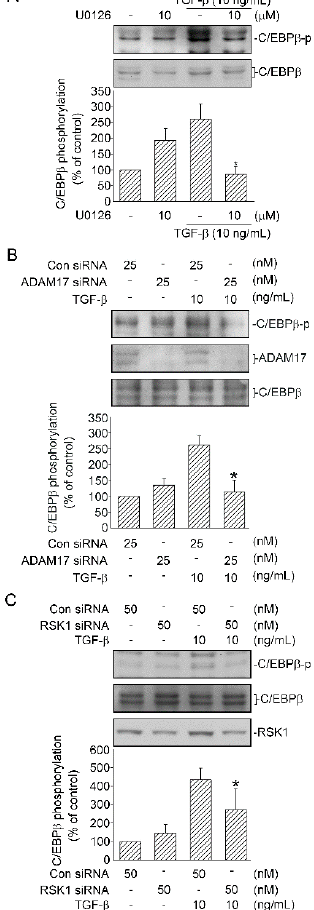
Figure 6. ERK, ADAM17, and RSK1 mediate TGF- β -induced C / EBP β in human lung epithelial A549 cells. ( A ) A549 cells were processed with the ERK inhibitor U0126 (10 µ M) for 20 min. After 20 min, the cells were treated with TGF- β (10 ng / mL) for an additional 20 min. C / EBP β phosphorylation and C / EBP β levels in cell lysates were immunodetected with specific antibodies. Data are expressed as mean ± SEM of three independent experiments. * p < 0.05, compared the TGF- β group without U0126 treatment. ( B ) A549 cells were transfected with control siRNA (con siRNA) and ADAM17 siRNA (25 nM). After 24 h, the cells were stimulated with TGF- β (10 ng / mL) for an additional 20 min. Cell lysates were prepared, and specific antibodies for C / EBP β phosphorylation and C / EBP β were immunodetected. Data are expressed as mean ± SEM of three independent experiments. * p < 0.05, compared with TGF- β plus the control siRNA group. ( C ) Cells were transfected with control siRNA (con siRNA) and RSK1 siRNA (50 nM) for 24 h before they were processed with TGF- β (10 ng / mL) for an additional 20 min. C / EBP β phosphorylation and C / EBP β were detected in cell lysates through Western blotting. Data are expressed as mean ± SEM of three independent experiments. * p < 0.05, compared with TGF- β plus the control siRNA